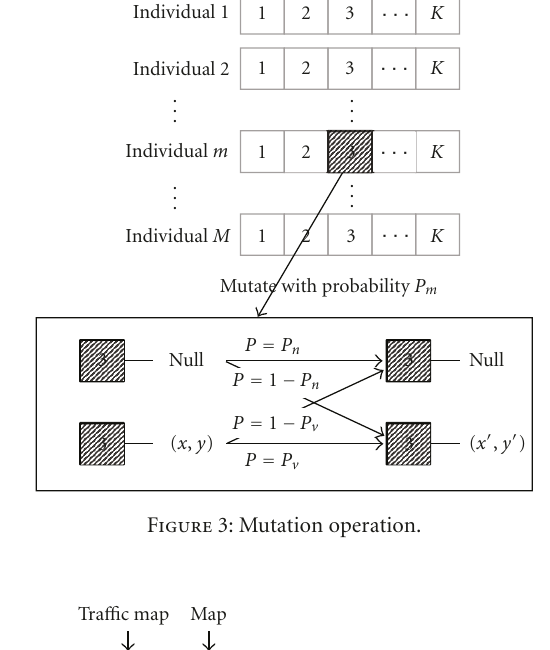
Figure 3: Mutation operation.